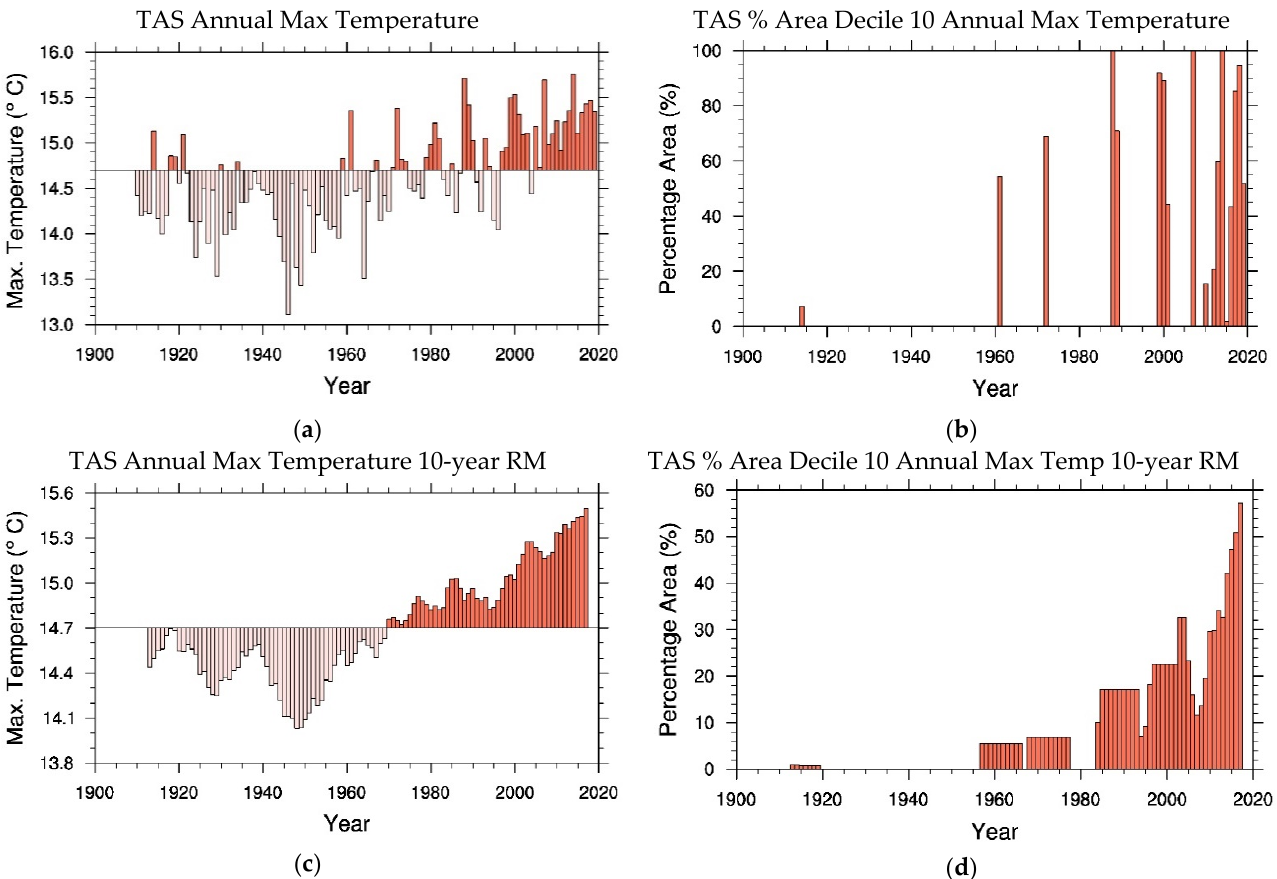
Figure 10. As in Figure 8 for TAS ( a ) maximum temperature, ( b ) decile 10 maximum temperature, ( c ) 10-year RM maximum temperature and ( d ) 10-year RM decile 10 maximum temperature.